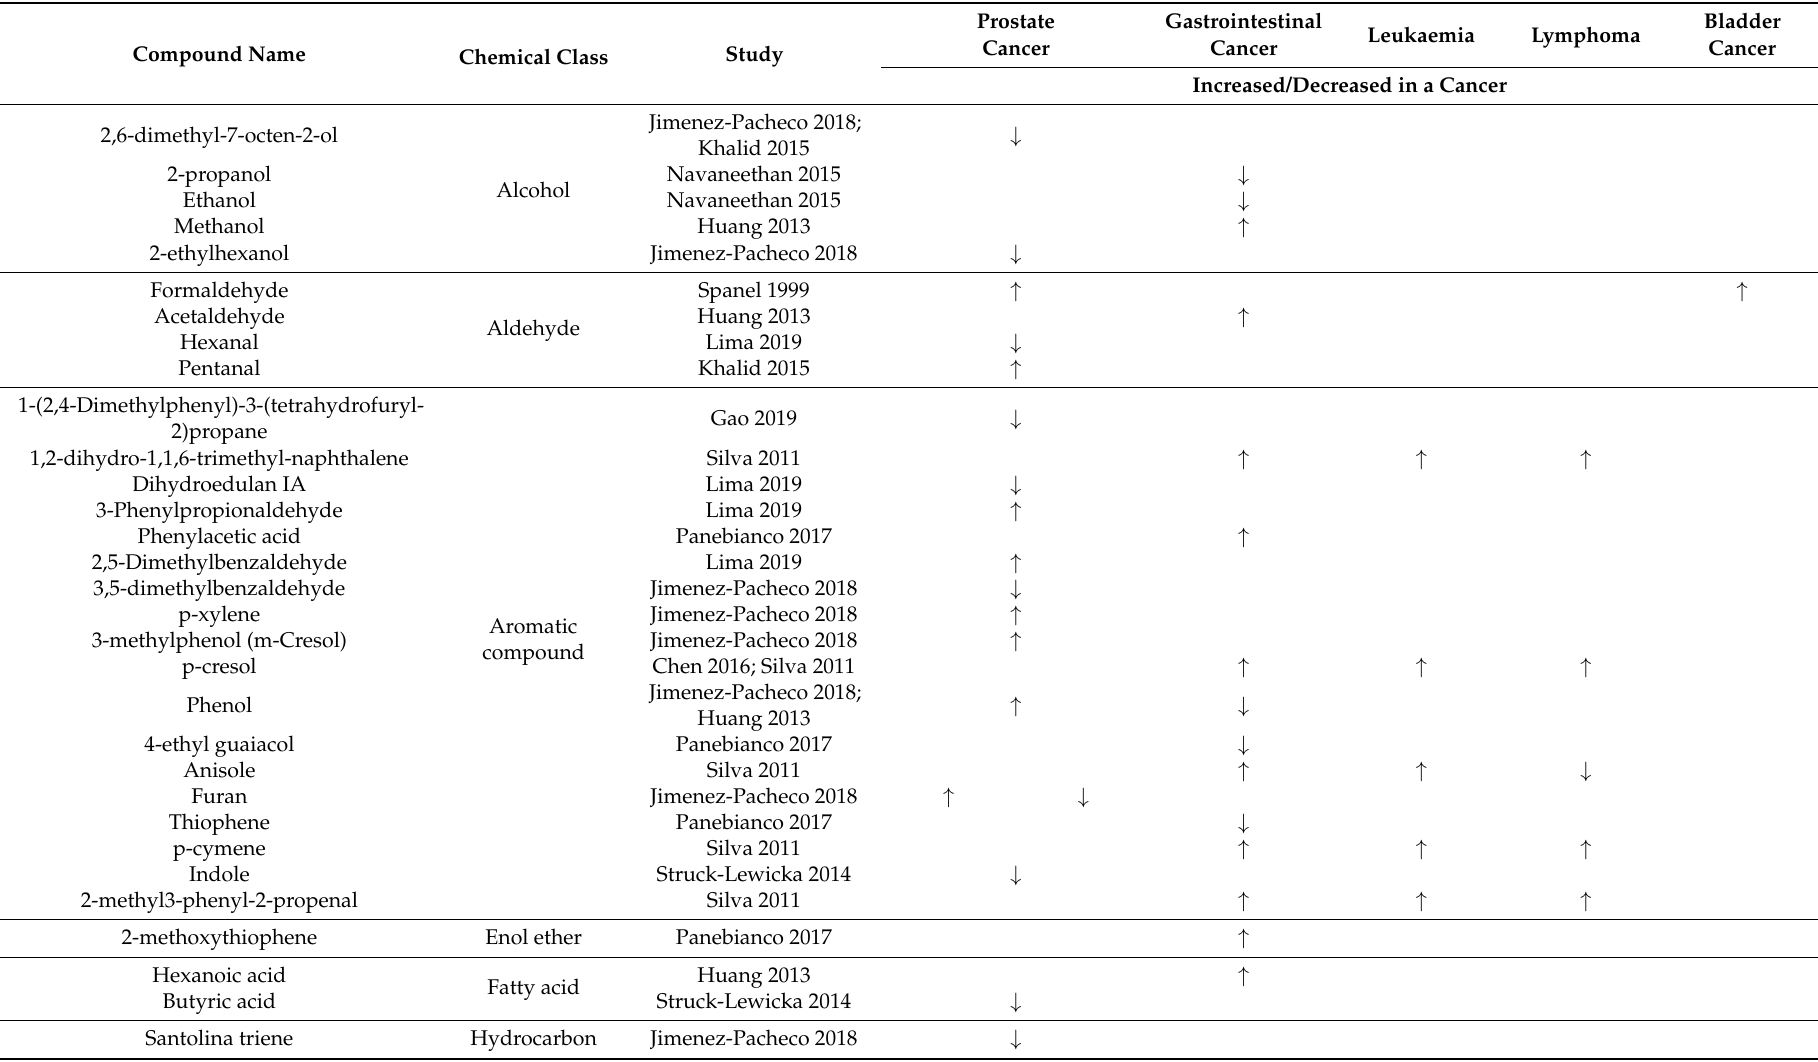
Table 3. List of all volatile organic compounds (VOCs), their chemical class, and studies that identified them to be increased or decreased in